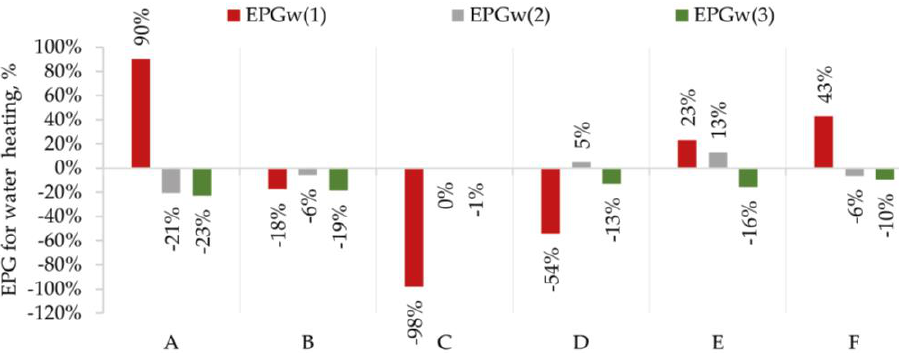
Figure 12. EPG for water heating for the analyzed parameters: EPG w (1) — hot water consumption, EPG w (2) — cold water temperature, EPG w (3) — hot water temperature.